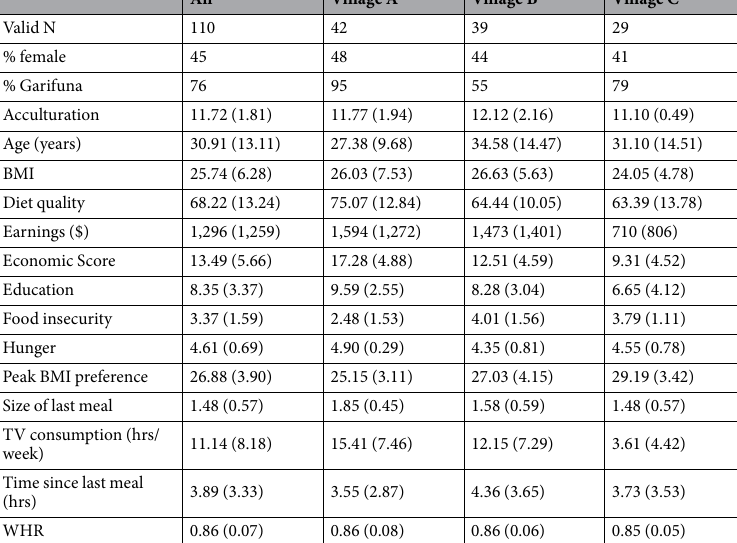
Table 2. Means and standard deviations of the main variables of the study. Age range for Village A, B and C was 17-60, 15–74, and 16–77,